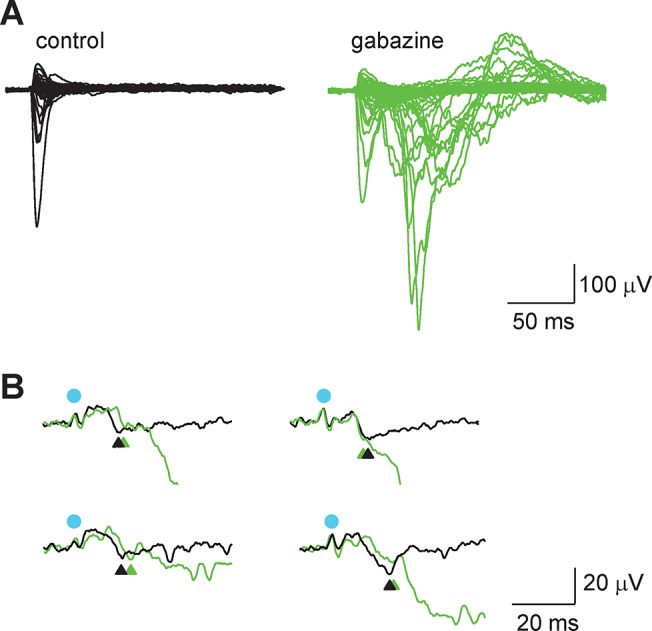
The block of GABAA receptors has little effect on fPSP postsynaptically.
A, Superposition of the 256 traces of a map recorded in layer 3 in control condition (black) and in the presence of gabazine (green). Blocking the synaptic inhibition increased and prolonged considerably the excitation of neurons stimulated by the uncaging of glutamate. B, Superposition of responses evoked by stimulating in layer 4 and recorded in control and in the presence of gabazine. The blue dots indicate the stimulation and the arrow heads the synaptic events chosen for the comparison of their slope.